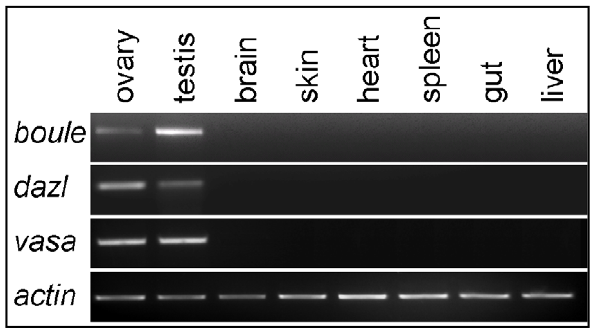
Figure 3. RT-PCR analysis of trout boule and dazl RNA expression. The RNA is abundant in the female gonad ovary and male gonad testis but absent in all somatic tissues examined.